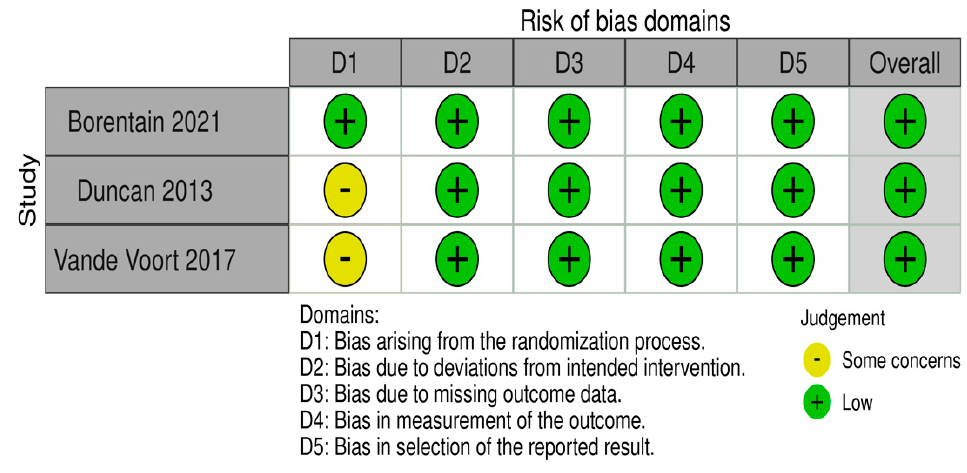
Figure 2. Risk of bias for randomised studies with the RoB 2 tool [29,41,42]. Table 2. Non-randomised study evaluated using Newcastle–Ottawa